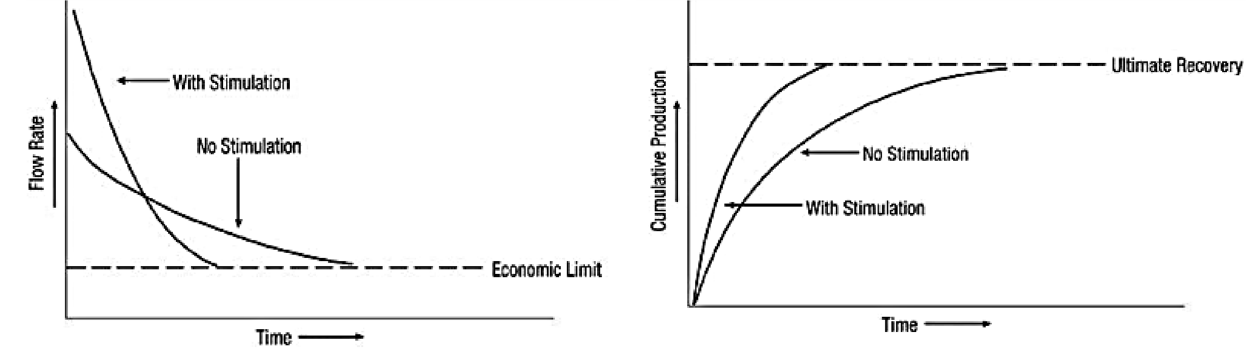
Fig. 1 The concept of production and recovery acceleration, high-permeability reservoirs (Holditch